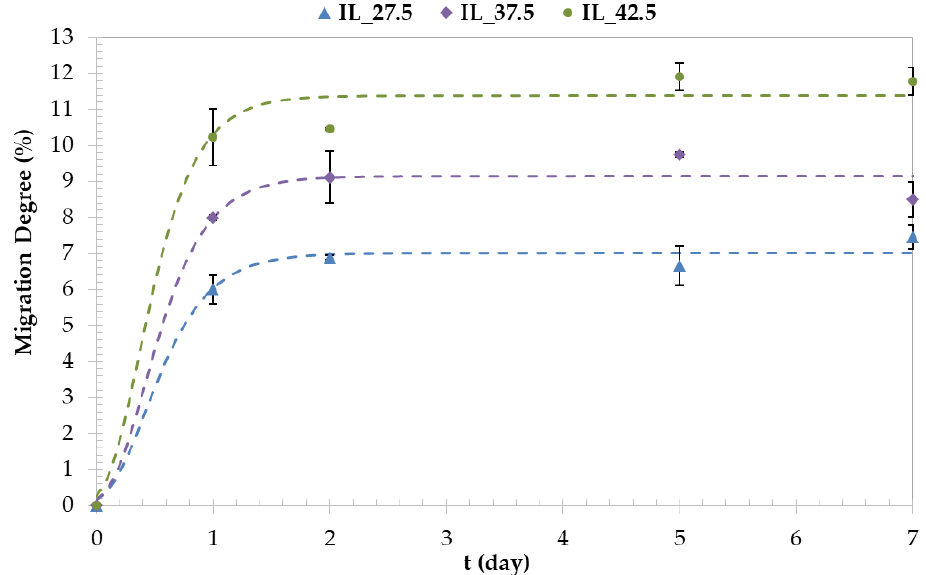
+ ][Ac − ] content of starch/PVA